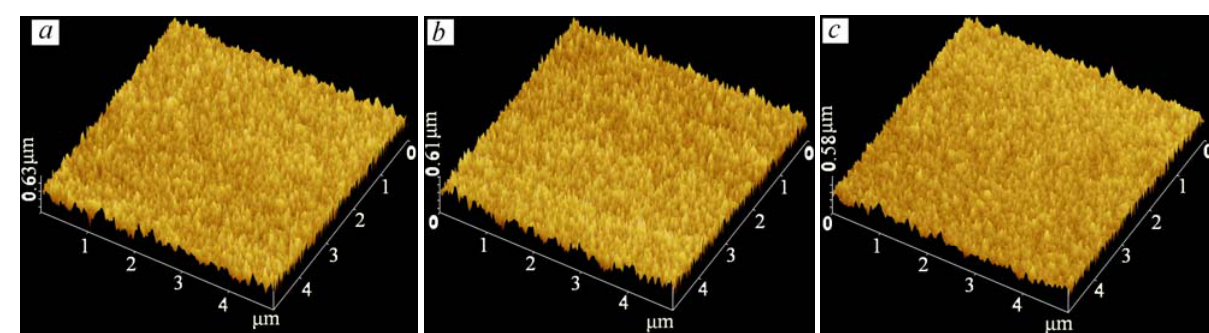
Figure 6. AFM micrograph of a sensing area of 5 × 5 μ m 2 for (a) x = 1, (b) x = 0.90, and (c) x =